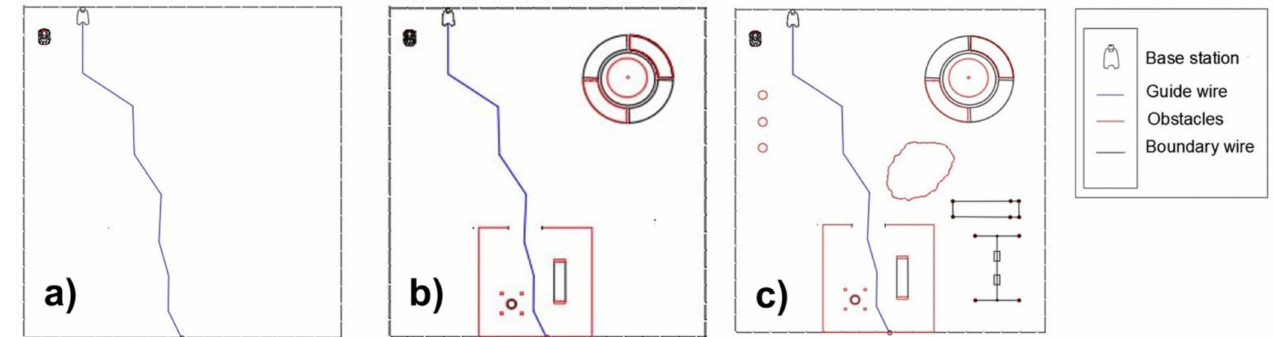
Figure 3. Garden designs scheme studied: ( a ) Garden A, without obstacles; ( b ) Garden B with a circular bench with a Lagerstroemia indica L. tree in centre and 2 pots with Delosperma cooperi flowers, a barbecue area with a bench, a barbecue, and a shed; ( c ) Garden C with a circular bench with a Lagerstroemia indica tree in the centre and 2 pots with Delosperma cooperi flowers, a barbecue area with a bench, a barbecue and a shed, 3 plants of Forsythia spp., a swing and a slide, 0.40 m wide parts not accessible by the robot, and a small